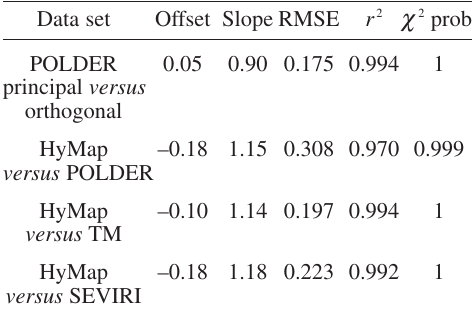
Table II. Statistics of the cross-comparison of LAI as retrieved using different data sets. Data set Offset Slope